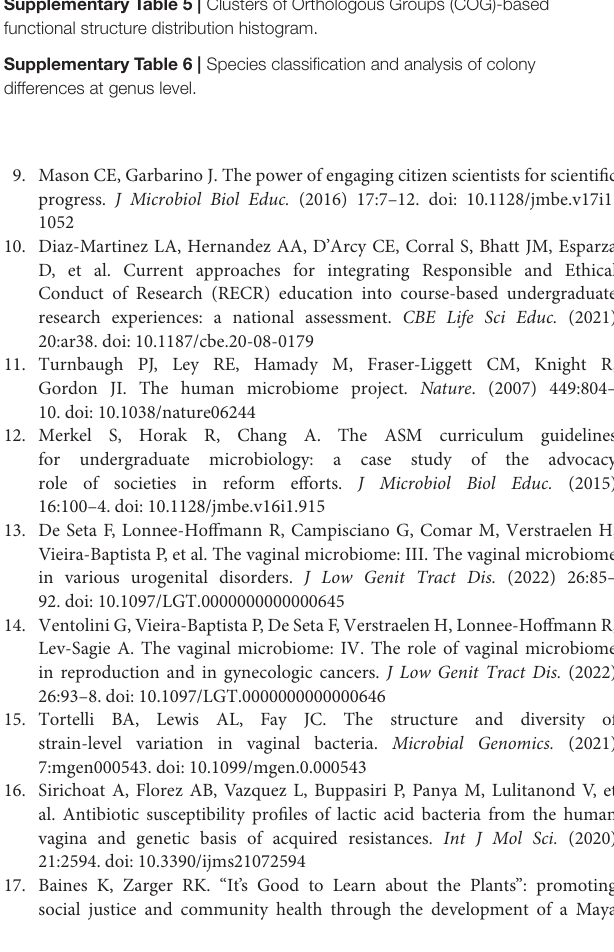
Supplementary Table 2 | Vaginal microorganism raw sequences. Supplementary Table 3 | Microbial relationship shared multi-dimensional analysis based on OTU cluster analysis and species classification. Supplementary Table 4 | Composition and Differences of Vaginal Microbial Diversity. Supplementary Table 5 | Clusters of Orthologous Groups (COG)-based functional structure distribution histogram. Supplementary Table 6 | Species classification and analysis of colony differences at genus